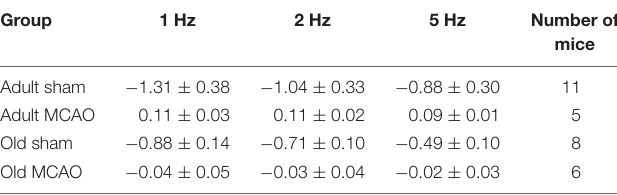
TABLE 2 | Local field potential